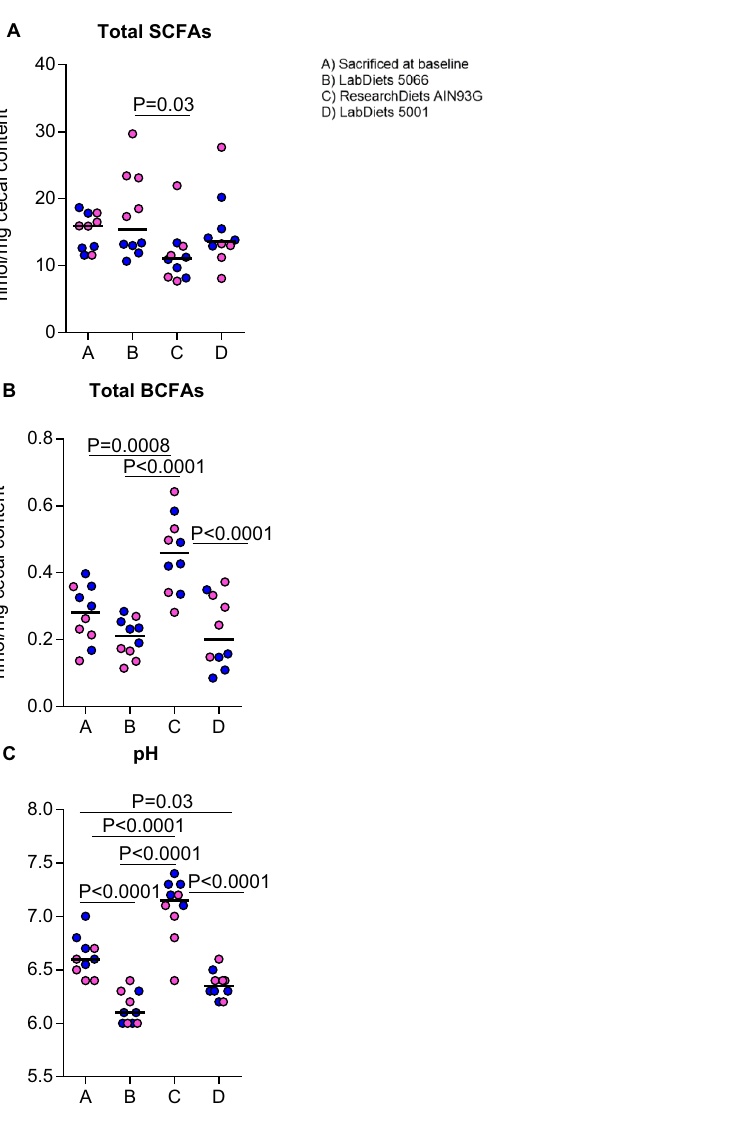
Figure 3. Analysis of cecal microbiota of mice receiving 4 different commercially available rodent diets. ( A ) Short-chain fatty acid (SCFA) content, ( B ) Branched-chain fatty acid content (BCFA), and ( C ) luminal pH. Females are shown here as pink dots and males as blue dots. Statistical analysis were conducted via one-way ANOVA or Kruskal Wallis test, as appropriate, and p values were corrected with Dunn’s multiple comparisons test or Tukey’s multiple comparison test, as appropriate. The Statistics were: χ 2 (24) = 8.974, p = 0.029 for A, F(3,36) = 14.49, p < 0.0001 for B, and F(3,36) = 41.17, p < 0.0001 for